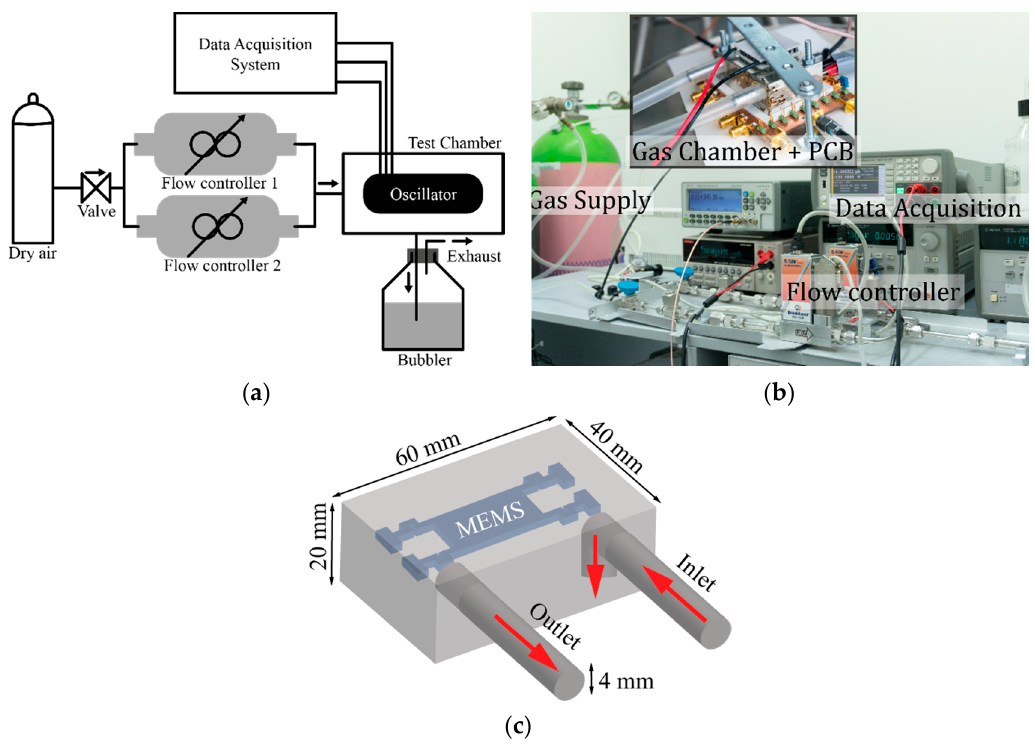
Figure 5. Experimental setup for gas flow test on CMOS-MEMS resonators: ( a ) schematic representation; ( b ) picture of the actual setup including the test equipment for system data acquisition; ( c ) diagram showing the gas chamber dimensions and the relative position of the fluid flow over the MEMS resonator.